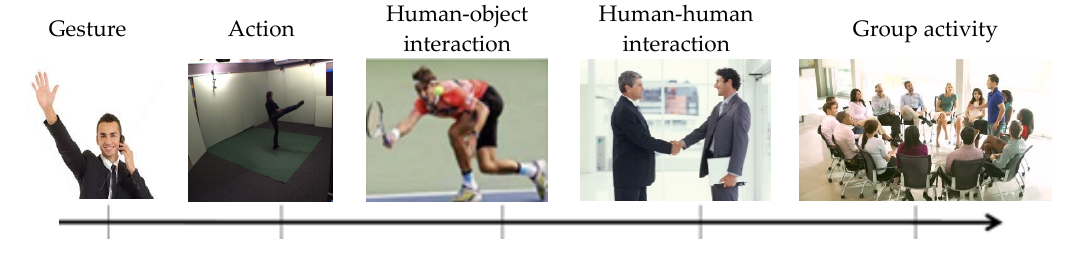
Figure 1. Categorization of different level of activities.